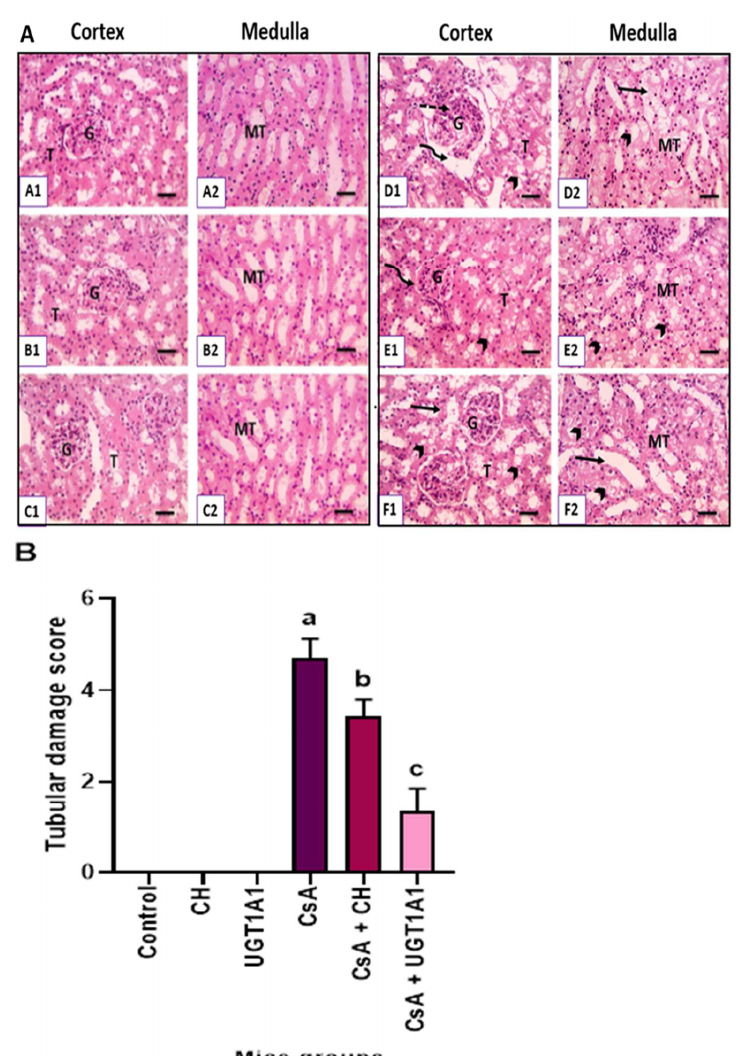
Figure 5. ( A ) Photomicrograph of kidney sections in different experimental groups (H&E; X: 400). Normal histological structure of cortical glomeruli (G) and tubules (T) beside normal medullary tubules (MT) in kidney sections of the control group (A1,A2), CH-treated group (B1,B2), and UGT1A1 antisense oligonucleotide-treated group (C1,C2). Glomerular hypertrophy dilated Bowman’s space (curved arrow) with mesangial proliferation (dashed arrows), tubular degeneration in the cortex (arrowheads), tubular degeneration (arrowheads), and necrosis (black arrows) in the medulla in kidney sections of the CsA-treated group (D1,D2). Narrowed Bowman’s space (curved arrow), mild to moderate tubular degeneration in the cortex (arrowheads), and tubular degeneration in the medulla (arrowheads) in kidney sections of the CsA + CH treated group (E1,E2). Very mild tubular dilation (black arrows) and degeneration (arrowheads) in cortex and medulla in kidney sections of the CsA + UGT1A1 antisense oligonucleotide-treated group (F1,F2). ( B ) Semiquantitative analysis of renal tissue lesions based on tubular damage score in different experimental groups. Values are expressed as mean ± SEM ( n = 8). Means of different letters are statistically different ( p < 0.05). (ANOVA; Duncan’s post hoc analysis).